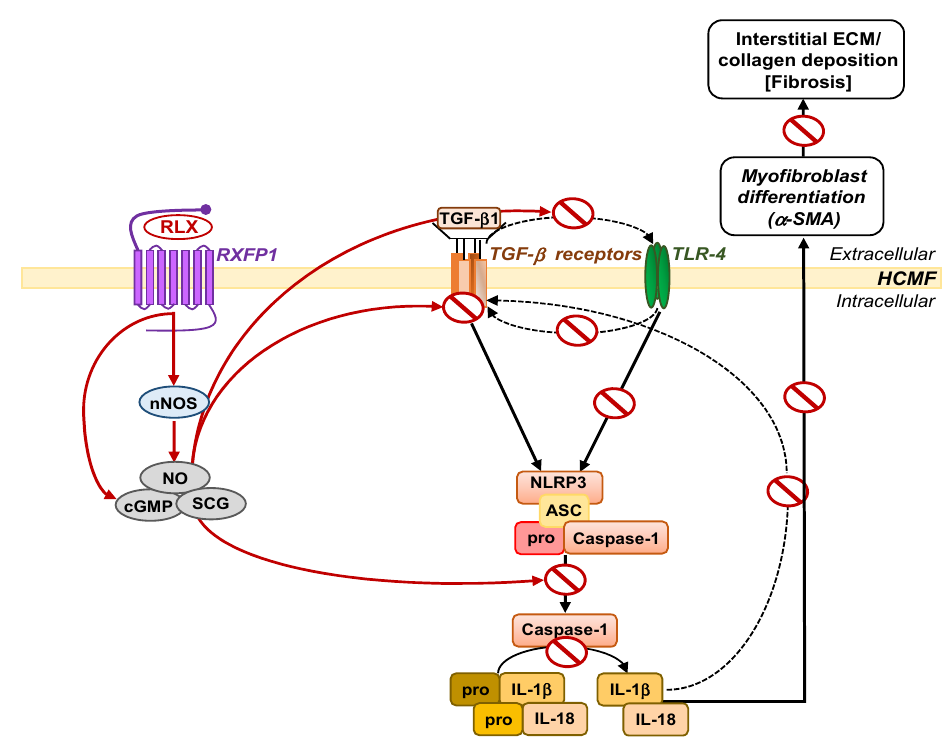
Figure 1. A schematic illustration of the signal transduction mechanisms by which RLX inhibits the myofibroblast NLRP3 inflammasome to mediate its anti-fibrotic actions. In RXFP1-expressing HCMFs, RLX can directly activate cGMP [29] or indirectly activate cGMP via nNOS (and a nNOS- NO-sGC-cGMP-dependent pathway [30,31]), to inhibit TLR-4 (upstream of the myofibroblast NLRP3 inflammasome) [34], as well as caspase-1 (at the level of the myofibroblast NLRP3 inflammasome) [35], as a means of disrupting the pro-fibrotic TGF- β 1/IL-1 β and TGF- β 1/IL-18 axes. This results in the RLX-induced inhibition of TGF- β 1/IL-1 β and TGF- β 1/IL-18-induced myofibroblast differentiation and myofibroblast-mediated ECM/collagen deposition (fibrosis).